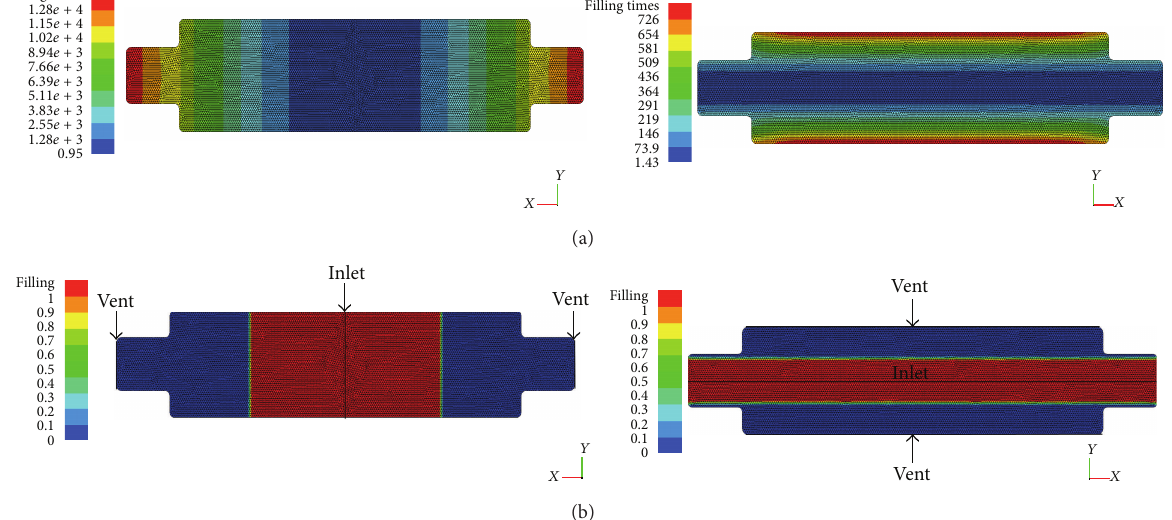
Figure 12: PAM-RTM simulation results for the two resin infusion strategies proposed for the fabrication of a longboard: (a) filling time; (b) flow front